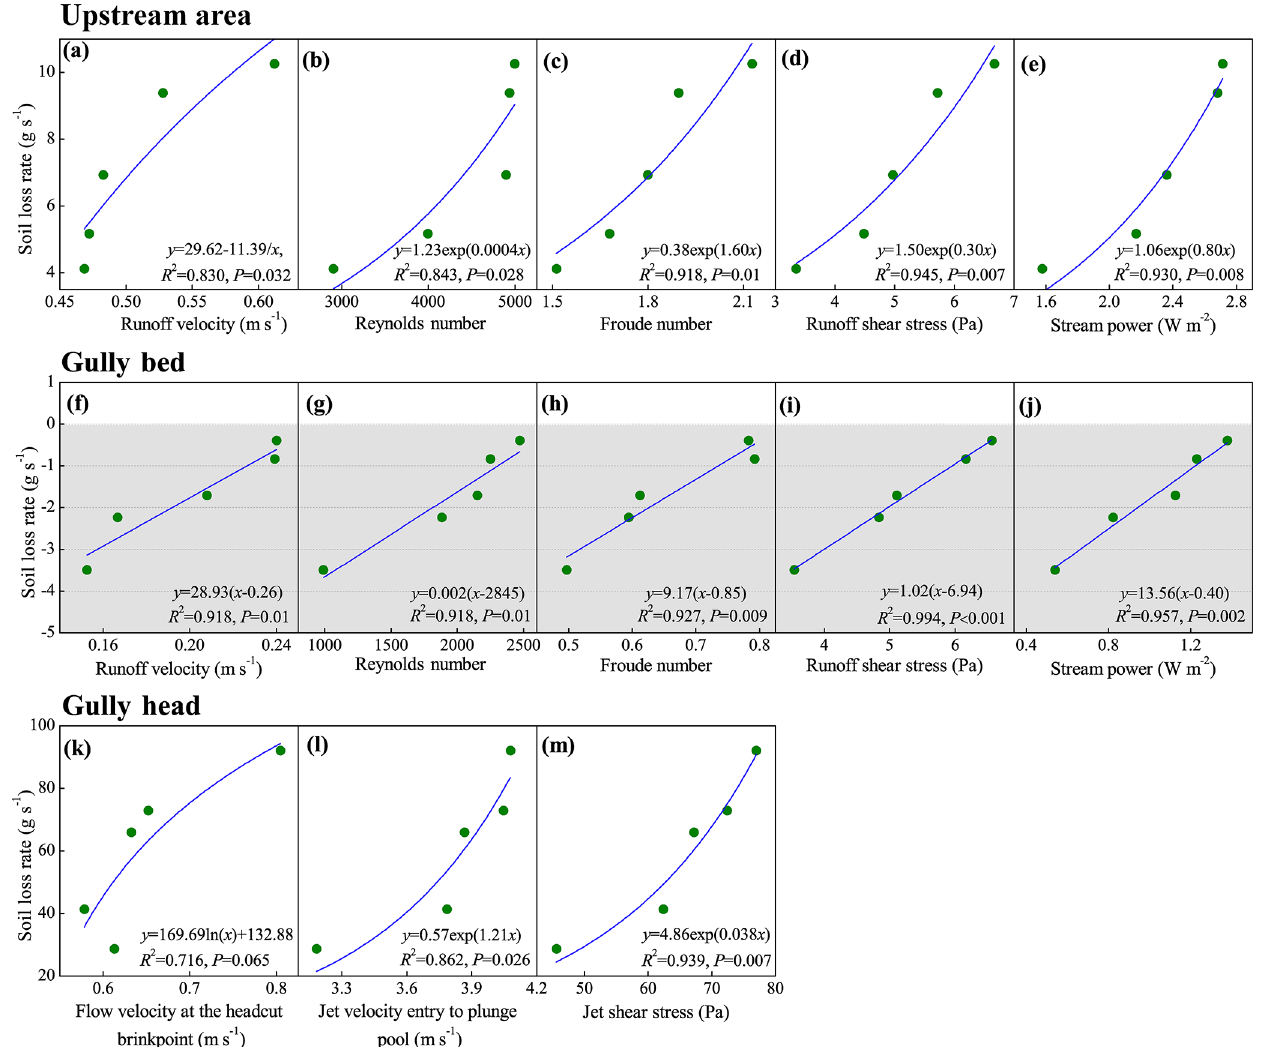
Figure 12. Relationships between soil loss rate of upstream area, gully bed, and gully head and runoff hydraulic and jet